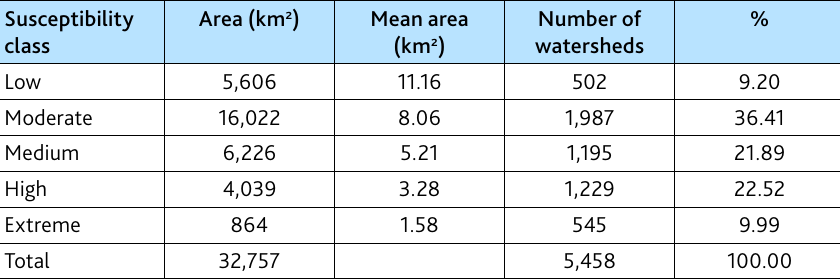
Table 2. Watershed statistics of the FFSI